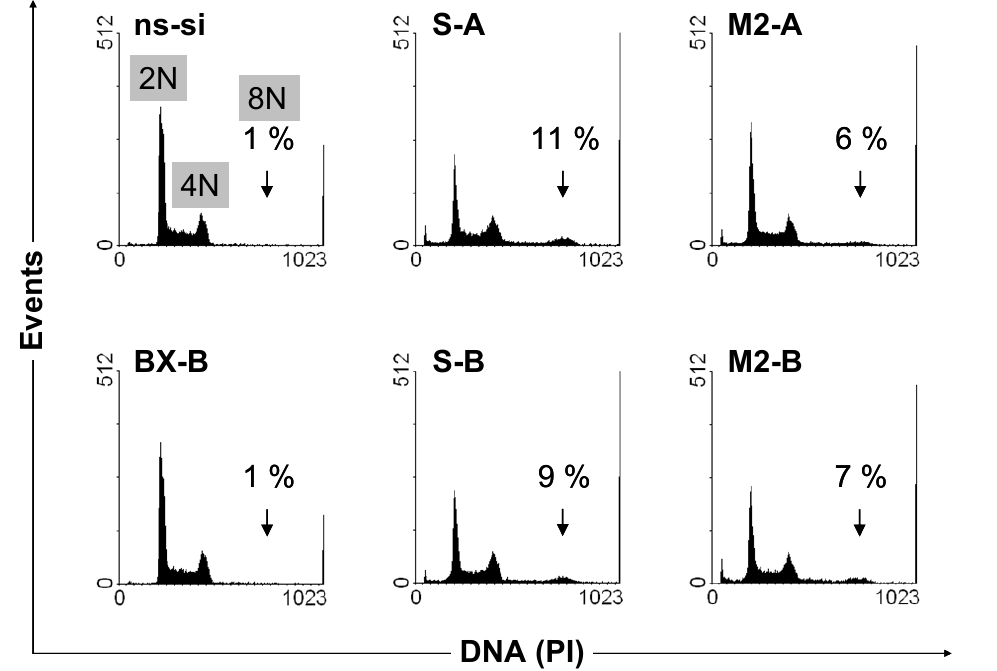
Figure 3. Induction of polyploidy after knockdown of survivin in single target and target combination treatments. DNA content of EJ28 cells, 48 h after single and combined siRNA-mediated inhibition of Bcl-xL and survivin, is shown. Arrows point at polyploid cells with DNA content of 8N. Representative images of two independent experiments are